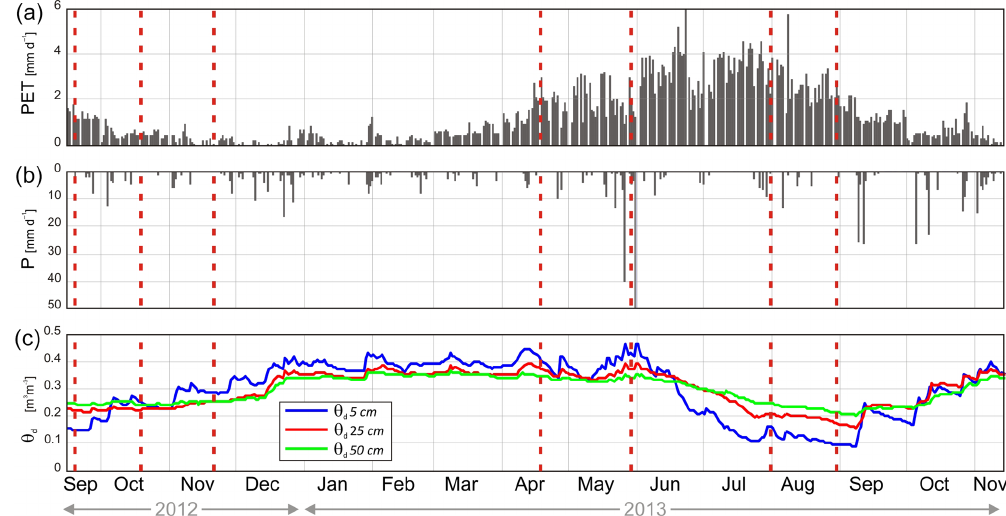
Figure 2. Time series of (a) daily potential evapotranspiration (PET), (b) daily cumulative precipitation ( P ), and (c) daily average soil mois- ture at the three depths of observation ( θ d,05 , θ d,25 , and θ d,50 , respectively). Vertical dotted lines indicate the dates of the EMI measurements: 19 September 2012, 18 October 2012, 20 November 2012, 18 April 2013, 28 May 2013, 31 July 2013, and 29 August 2013 (Martini et al., 2015, modified).